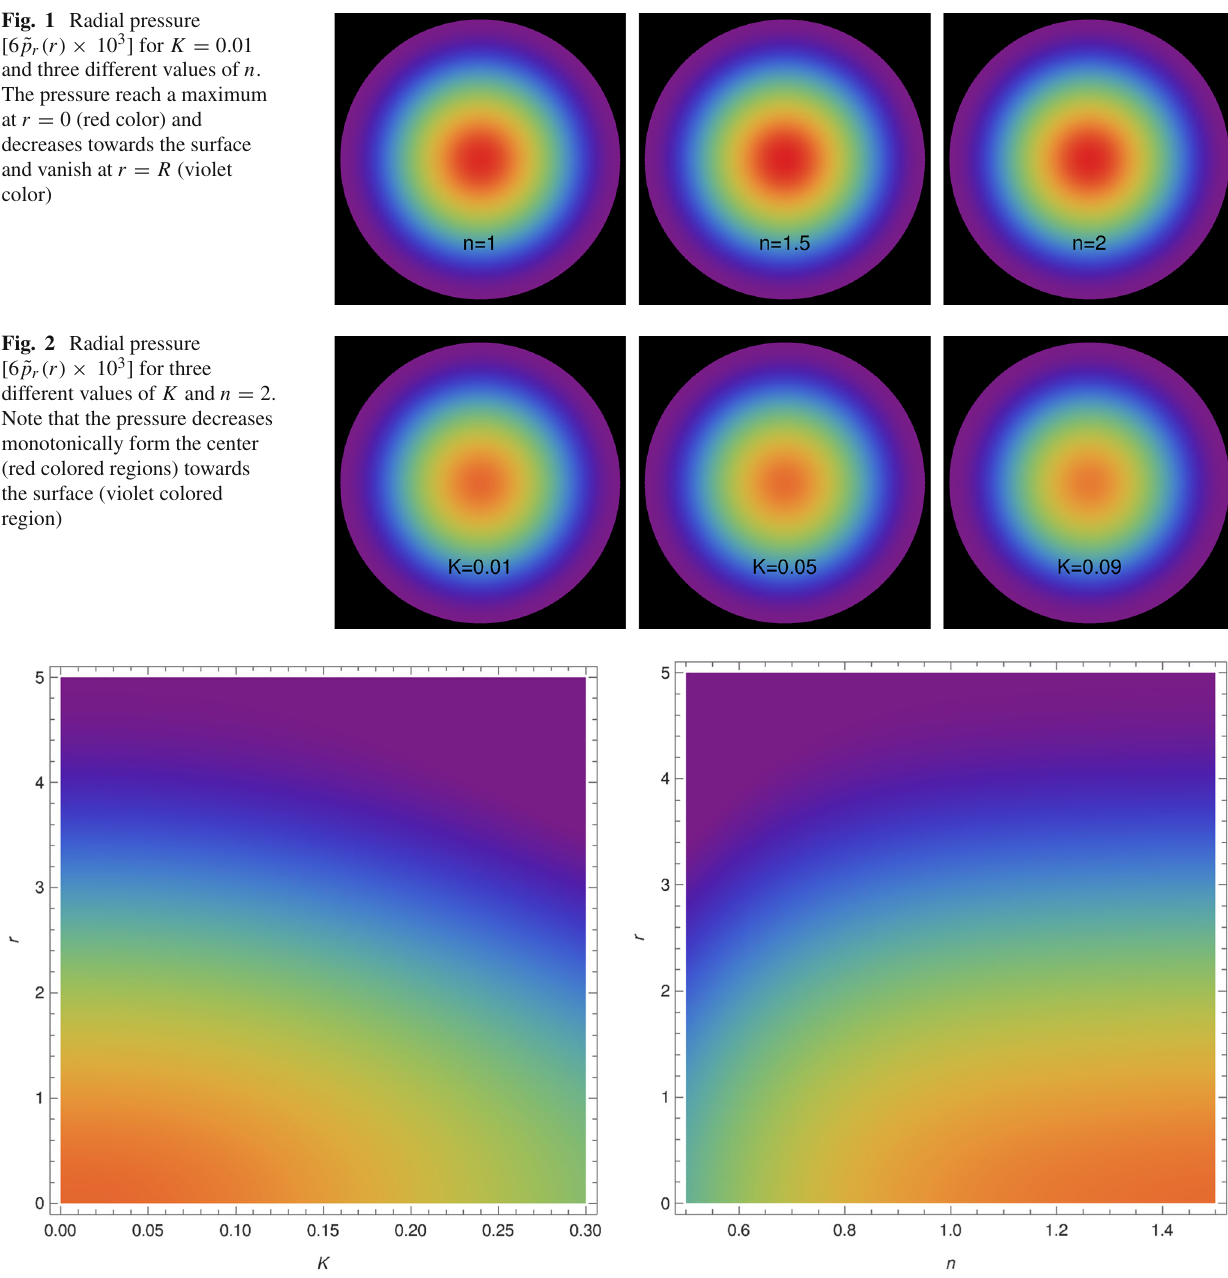
Fig. 1 Radial pressure [ 6 ˜ p ( r ) × 10 3 ] for K = 0 . 01 r and three different values of n . The pressure reach a maximum at r = 0 (red color) and decreases towards the surface and vanish at r = R (violet color)